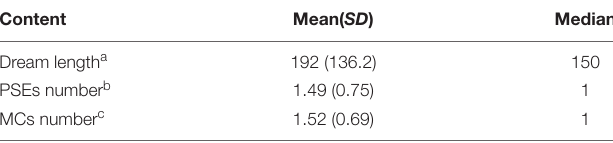
TABLE 2 | Average and median number of dream length and conscious